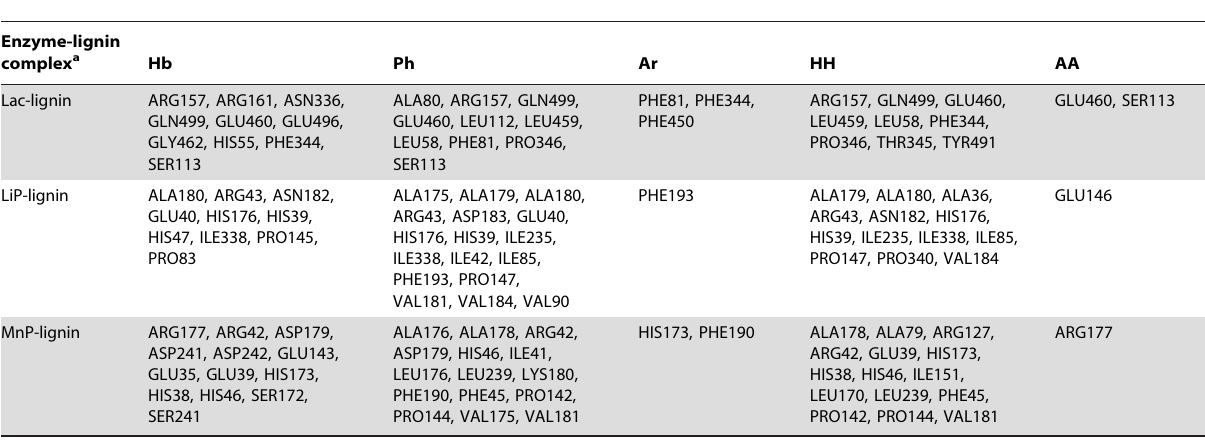
Table 2. Interactional residues of ligninolytic enzymes with lignin.